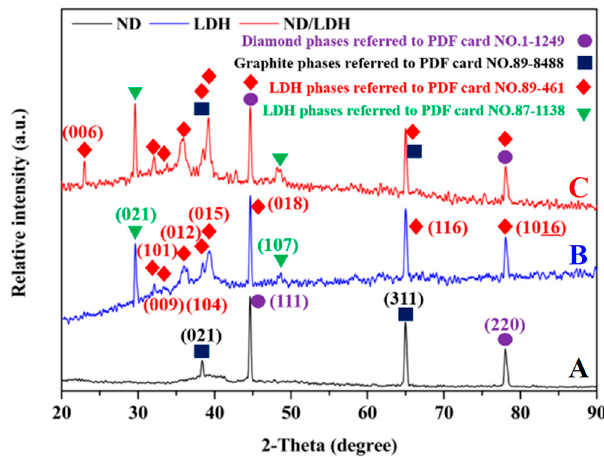
Figure 2. X-ray diffraction (XRD) spectra of ND ( A ), LDH ( B ) and ND/LDH ( C ). Figure 2. X ‐ ray diffraction (XRD) spectra of ND ( A ), LDH ( B ) and ND/LDH ( C ). The surface state of ND/LDH was investigated with the XPS method. The full-range XPS spectra is represented in Figure 3a, where peaks corresponding to C 1s, Cu 2p and Fe 2p were detected. The sharp peak of C 1s was composed of four splitting peaks at 284.39, 284.96, 286.06 and 287.83 eV (Figure 3b). 284.96 eV suggested sp3-hybridized carbon, indicating the existence of ND. 284.39 eV suggested sp2-hybridized carbon, indicating partial graphitization on the surface of ND, which was consistent with the XRD results. 286.06 and 287.83 eV suggested C-O and C=O structures, respectively, attributed to the oxygen-containing groups on the surface of ND [38]. For Cu 2p (Figure 3c), two typical peaks were located at 954.62 and 934.64 eV, corresponding to Cu 2p 1/2 and Cu 2p 3/2 . Correspondingly, the other two peaks, at 942.68 and 962.75 eV, were the satellite peaks of Cu 2p. These results suggest that the copper in ND/LDH appeared as Cu 2+ with the outermost electron configuration of 3d 9 [39–42]. For Fe 2p (Figure 3d), the XPS peak of Fe 2p 1/2 was located at 724.69 eV, and the peak of Fe 2p 3/2 was composed of two splitting peaks at 711.38 and 714.05 eV, indicating that iron in ND/LDH appeared as Fe 3+ with the outermost electron configuration of 3d 5